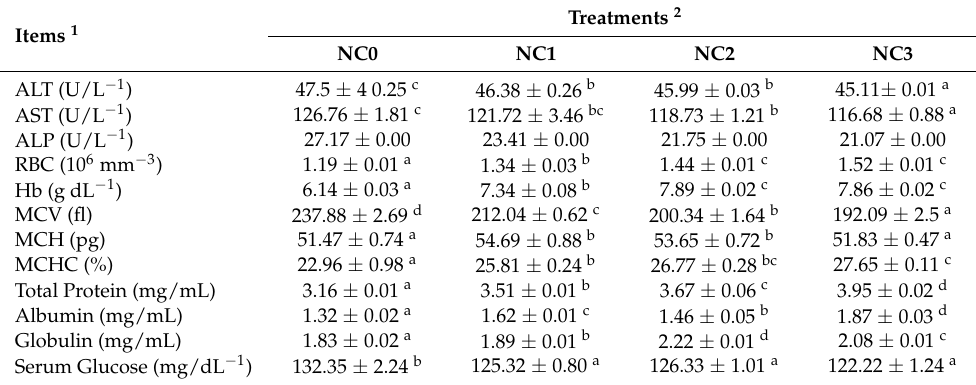
Table 4. Biochemical indices of red tilapia ( Oreochromis sp.) after 56-day-feeding trial.